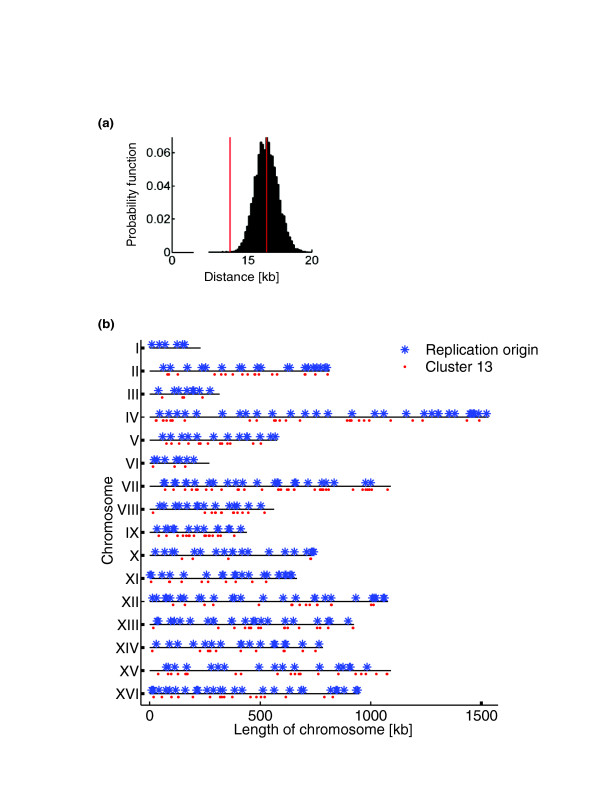
Chromosomal location of replication origins (blue replication origins) and ORFs from cluster 13 (red dots). A randomization test revealed that the average ORFs are much closer to the replication origins than would be expected by chance. (a) The actual and expected average distance between ORFs and replication origins are shown with red lines to the left and right, respectively. The variation of the expected distance is indicated with a black histogram. (b) The genomic position of genes in cluster 13 (red dots) and replication origins (blue stars).